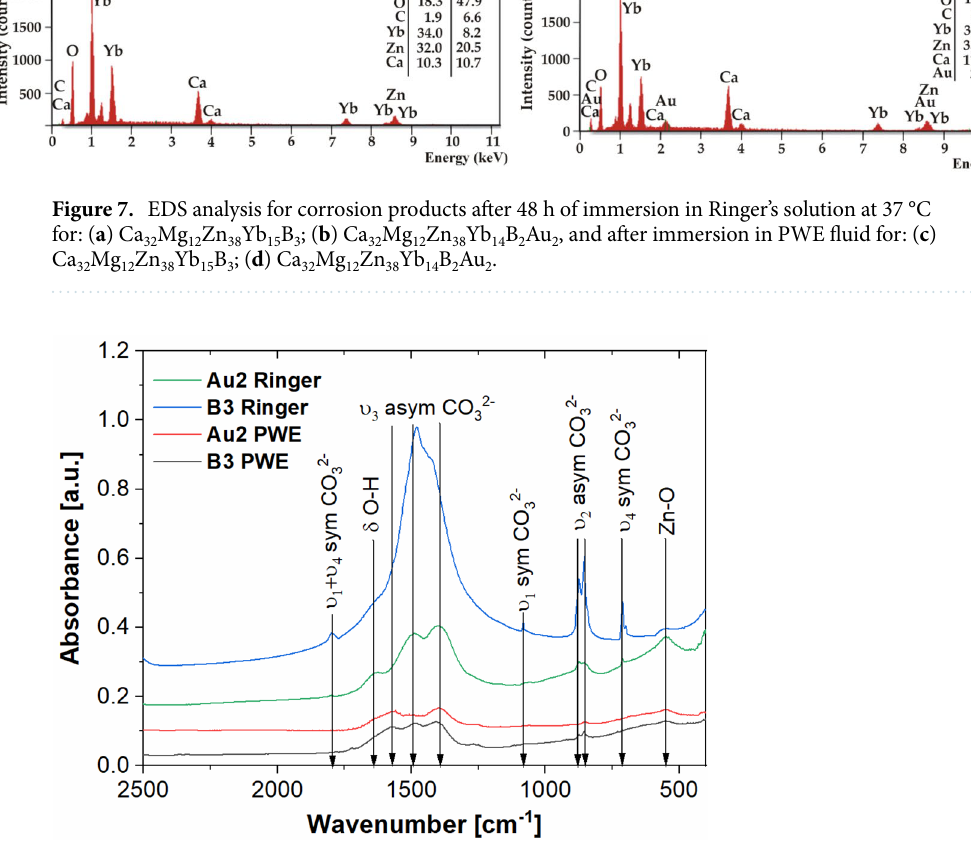
Figure 8. FTIR spectra of Ca 32 Mg 12 Zn 38 Yb 15 B 3 and Ca 32 Mg 12 Zn 38 Yb 14 B 2 Au 2 samples after immersion test in Ringer’s and PWE solutions with marked characteristic